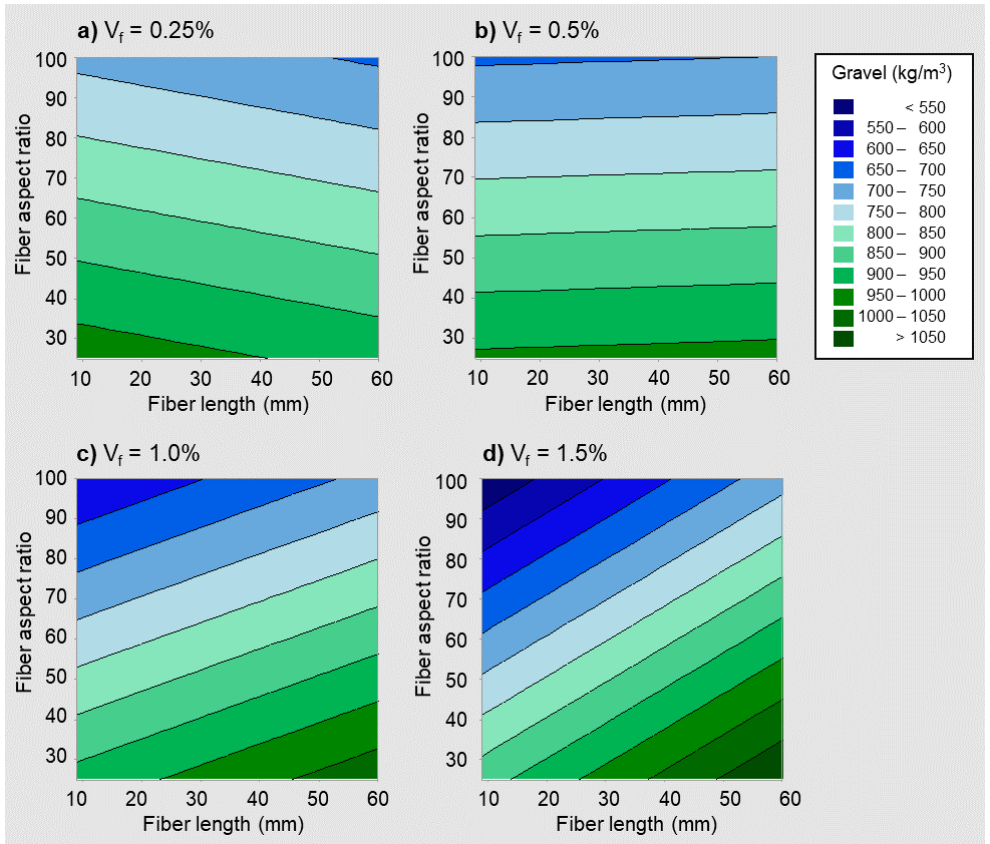
Figure 3. Coarse aggregate content versus fiber length and aspect ratio for different fiber dosages: contour plots for fiber volume fractions of 0.25% ( a ), 0.50% ( b ), 1.0% ( c ), 1.5% ( d ).